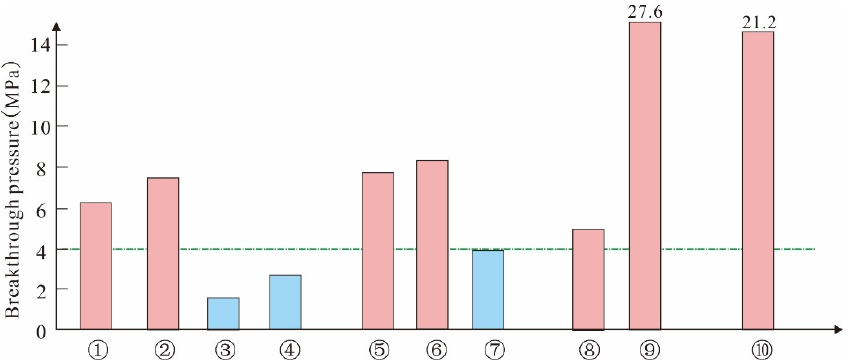
Figure 4. Comparison of the average breakthrough pressure of different lithological caprock layers. ① = micritic dolomite, ② = gypsum dolomite, ③ = fine crystalline dolomite, ④ = granular dolomite, ⑤ = micritic limestone, ⑥ = gypsum limestone, ⑦ = granular limestone, ⑧ = gypsum rock, ⑨ = salt rock, ⑩ = mudstone. Using 4 MPa as the boundary, those greater than 4 MPa are the dominant lithology, which are marked with red columns. (Data source: Wu et al., 2022 [ 9] ).